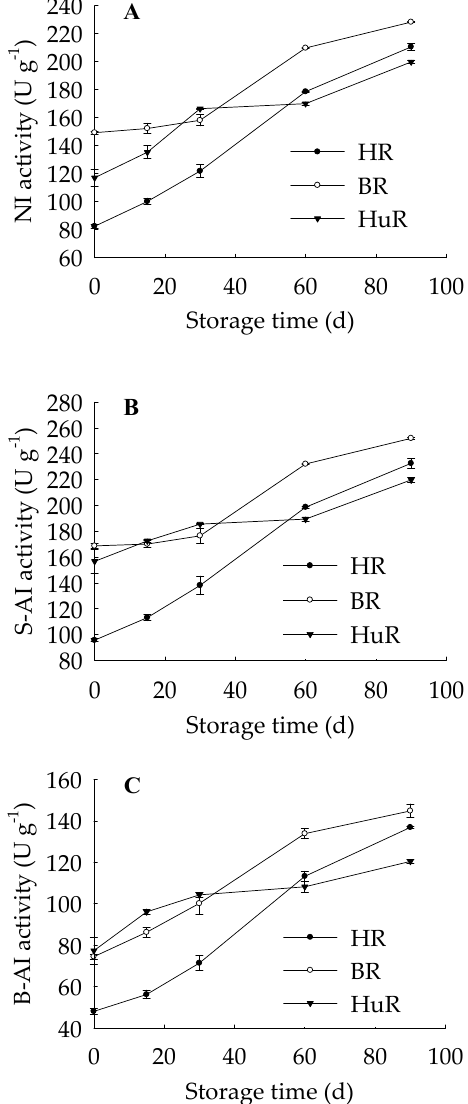
Figure 2. Changes in NI ( A ), S-AI ( B ), B-AI( C ) activities in juice sacs of three pumelo cultivars. Vertical bars represent SE of the means of three replicate assays. NI, neutral invertase; S-AI, soluble acid invertase; B-AI, cell wall insoluble acid invertase.